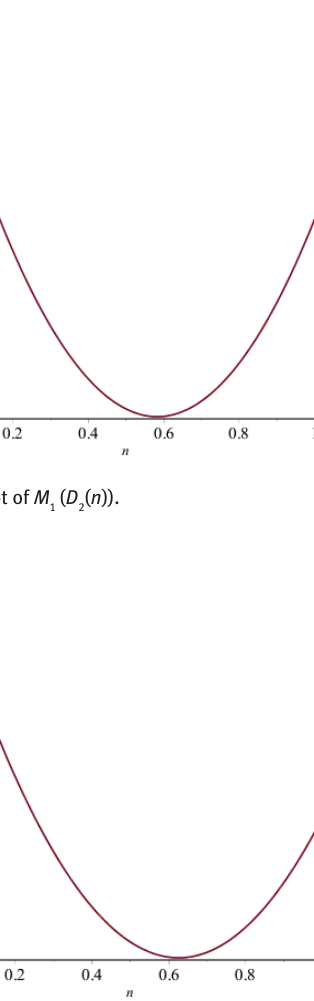
Figure 19: Plot of RR